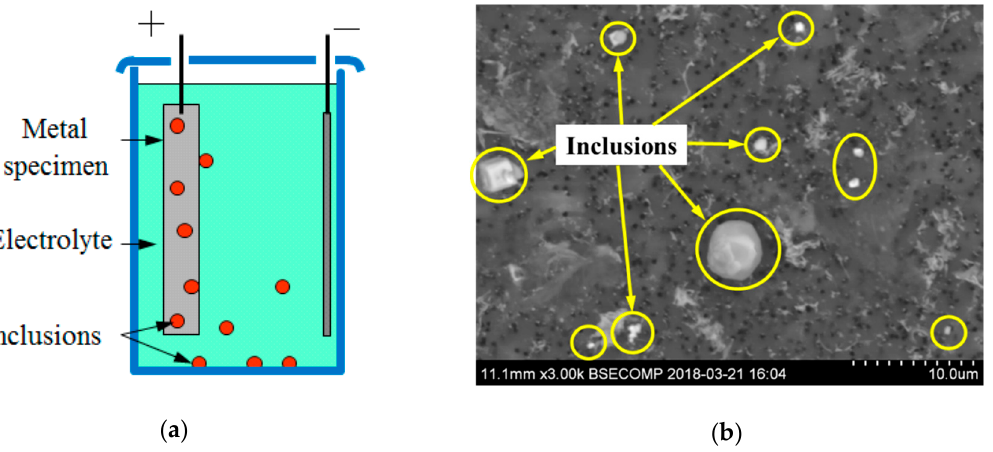
Figure 2. ( a ) Schematic illustration of the electrolytic extraction process; ( b ) SEM image of some typical non-metallic inclusions present on a film filter after a completed electrolytic extraction.